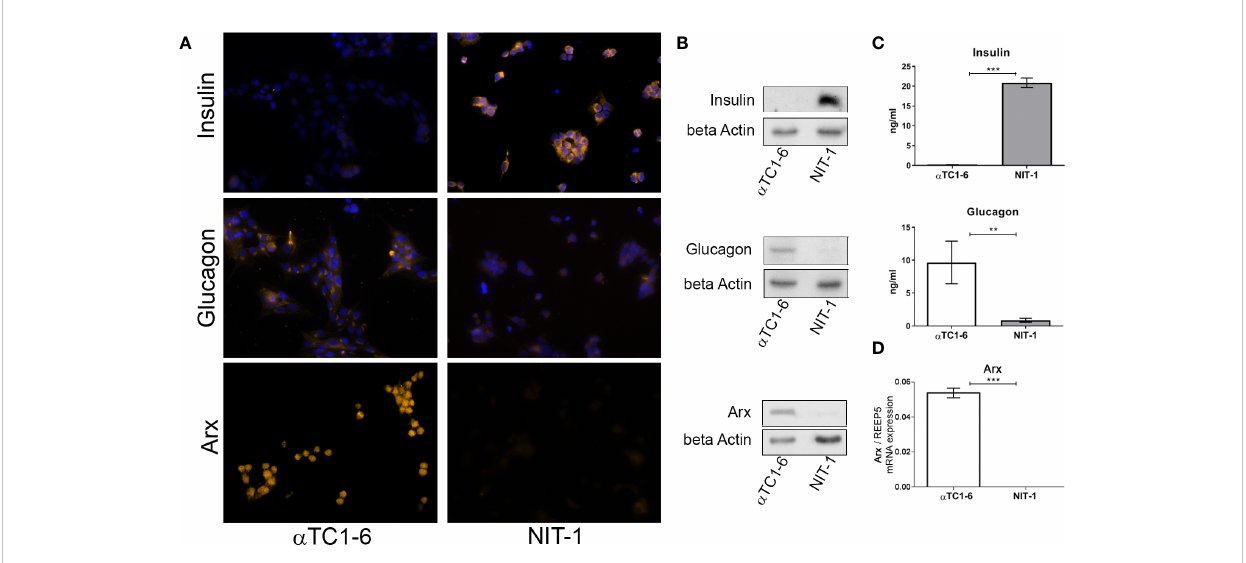
FIGURE 2 Insulin and glucagon as the main functional cell-type-speci fi c products. (A) Immuno fl uorescence analysis of a TC1-6 and NIT-1 cells with anti- insulin, anti-glucagon, and anti-Arx antibody (light orange fl uorescence). Nuclei were stained with DAPI (blue fl uorescence). DAPI was not added to cells labeled with anti-Arx antibody. (B) Protein expression of insulin, glucagon, and Arx in lysates isolated from a TC1-6 and NIT-1 cells were determined with immunoblot analysis using anti-insulin, anti-glucagon, anti-Arx, and anti- b -actin (loading control) antibodies. (C) The amount of secreted insulin and glucagon in cell culture media was measured by enzyme-linked immunosorbent assay (ELISA). (D) The relative expression level of Arx mRNA isolated from a TC1-6 and NIT-1 cells was determined by RT-qPCR analysis. The REEP5 mRNA level expression was used as an endogenous control. Data are displayed as mean ± SDs. The error bars denote SD from three biological replicates performed in technical duplicates. Signi fi cance among cell type samples was determined using an unpaired Students t-test, **p ≤ 0.01, ***p ≤